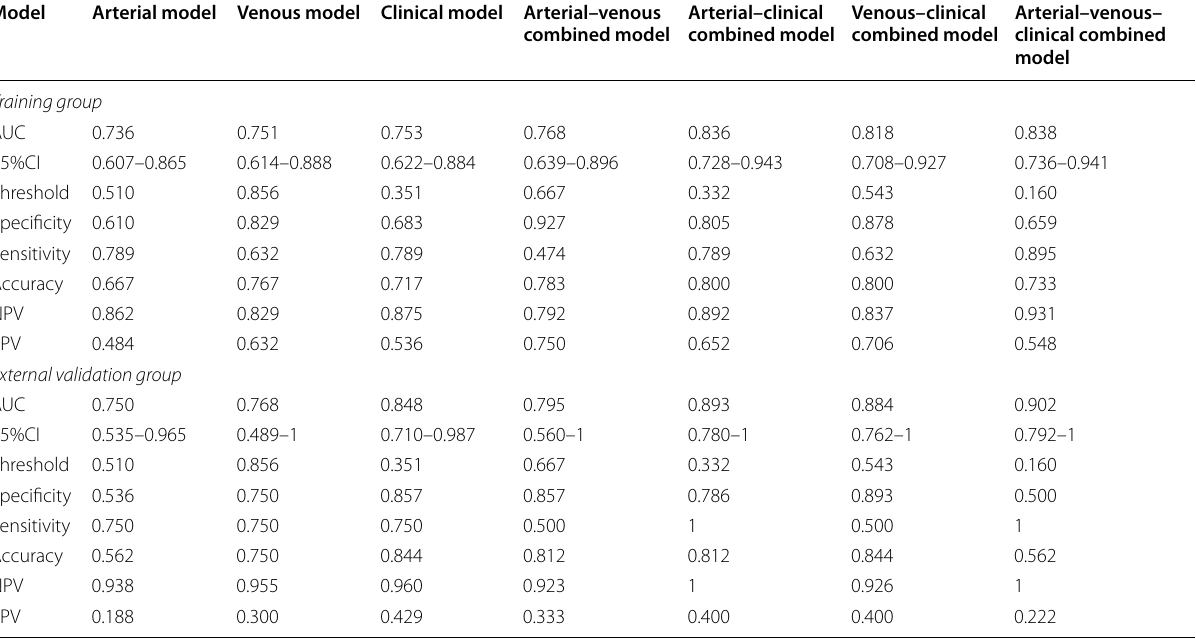
Table 2 Efficacy of different models in the training group and the external validation group for predicting pathological complete response (pCR)